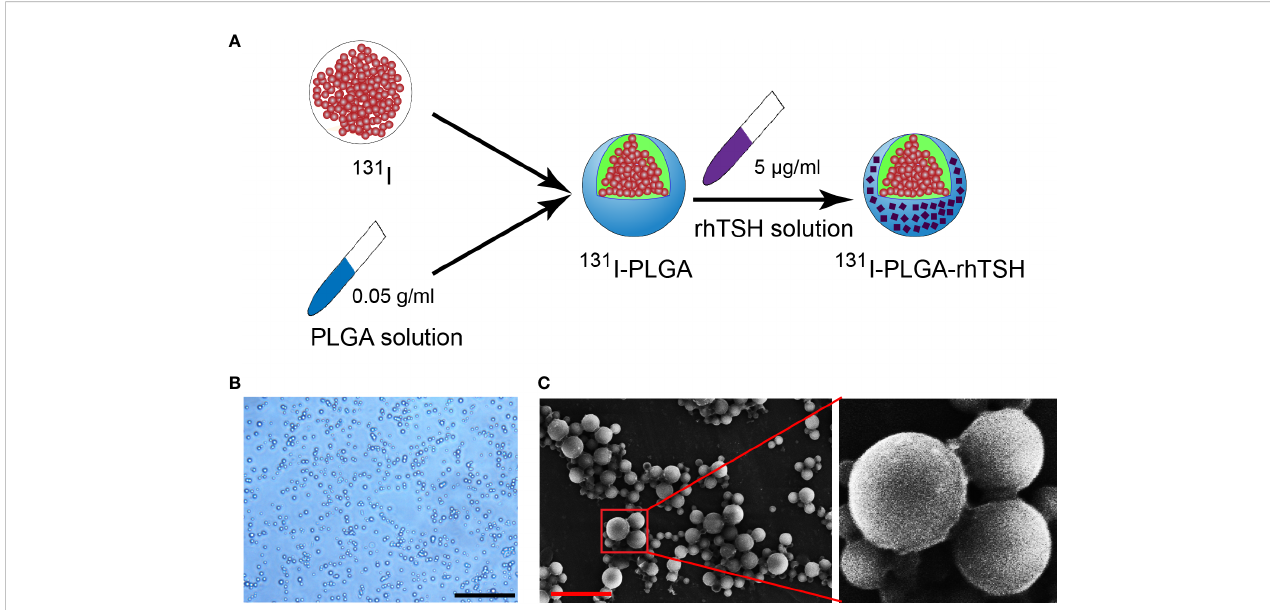
FIGURE 1 Generation of 131 I-PLGA-rhTSH nanoparticles. (A) The schematic illustration of developing 131 I-PLGA-rhTSH nanoparticles-encapsulated with 131 I using poly (lactic-co-glycolic acid) (PLGA) and decorated with rhTSH. (B) The phase-contrasted images illustrating the morphology of the 131 I-PLGA-rhTSH nanoparticles. Scale bar: 5 m m. (C) Scanning electron microscopy (SEM) images presenting the morphology of 131 I-PLGA-rhTSH nanoparticles. Scale bar: 1 m